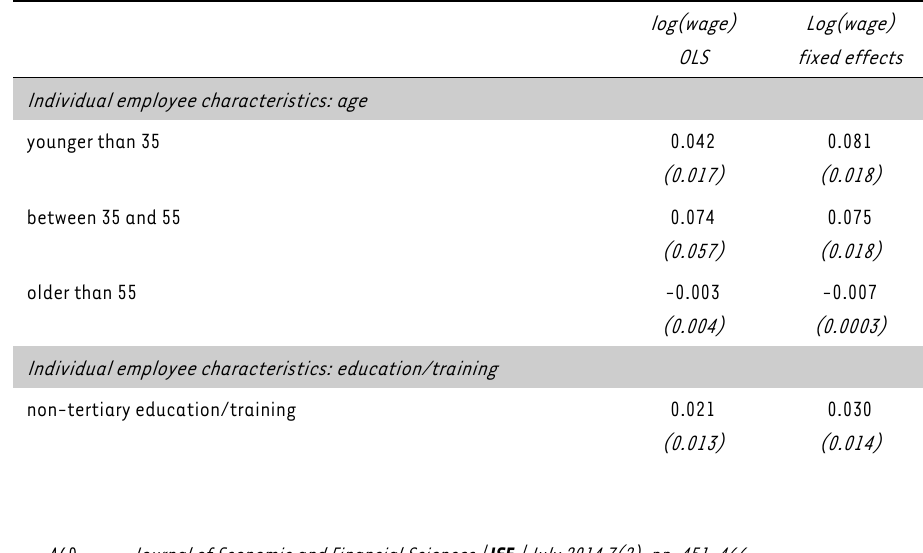
Individual employee relational remuneration model